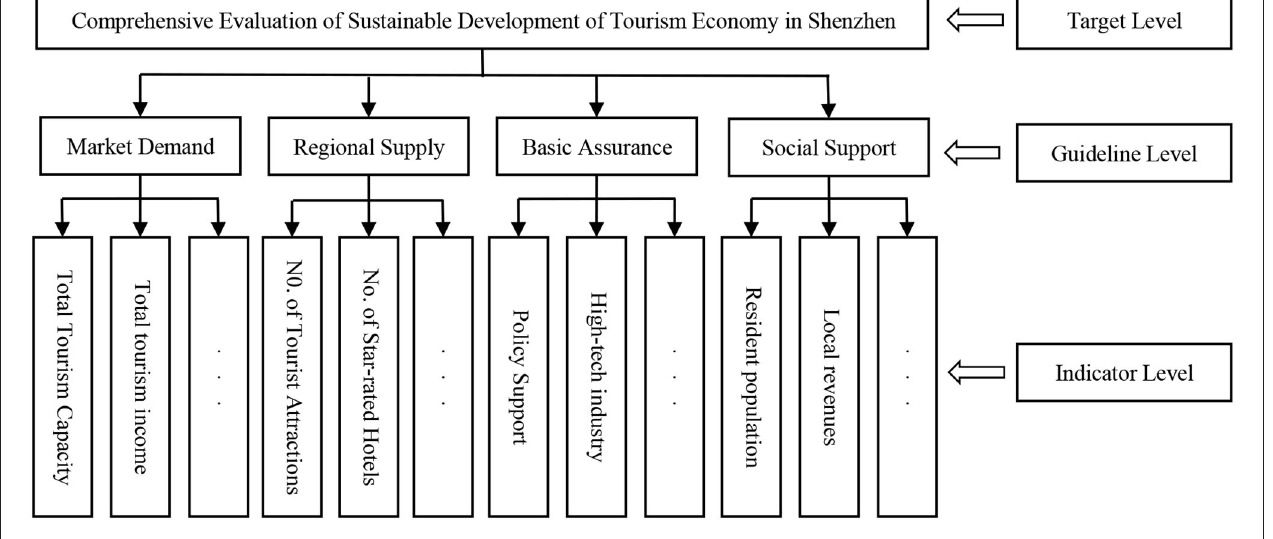
FIGURE 3 | Hierarchical model of sustainable development of tourism economy in